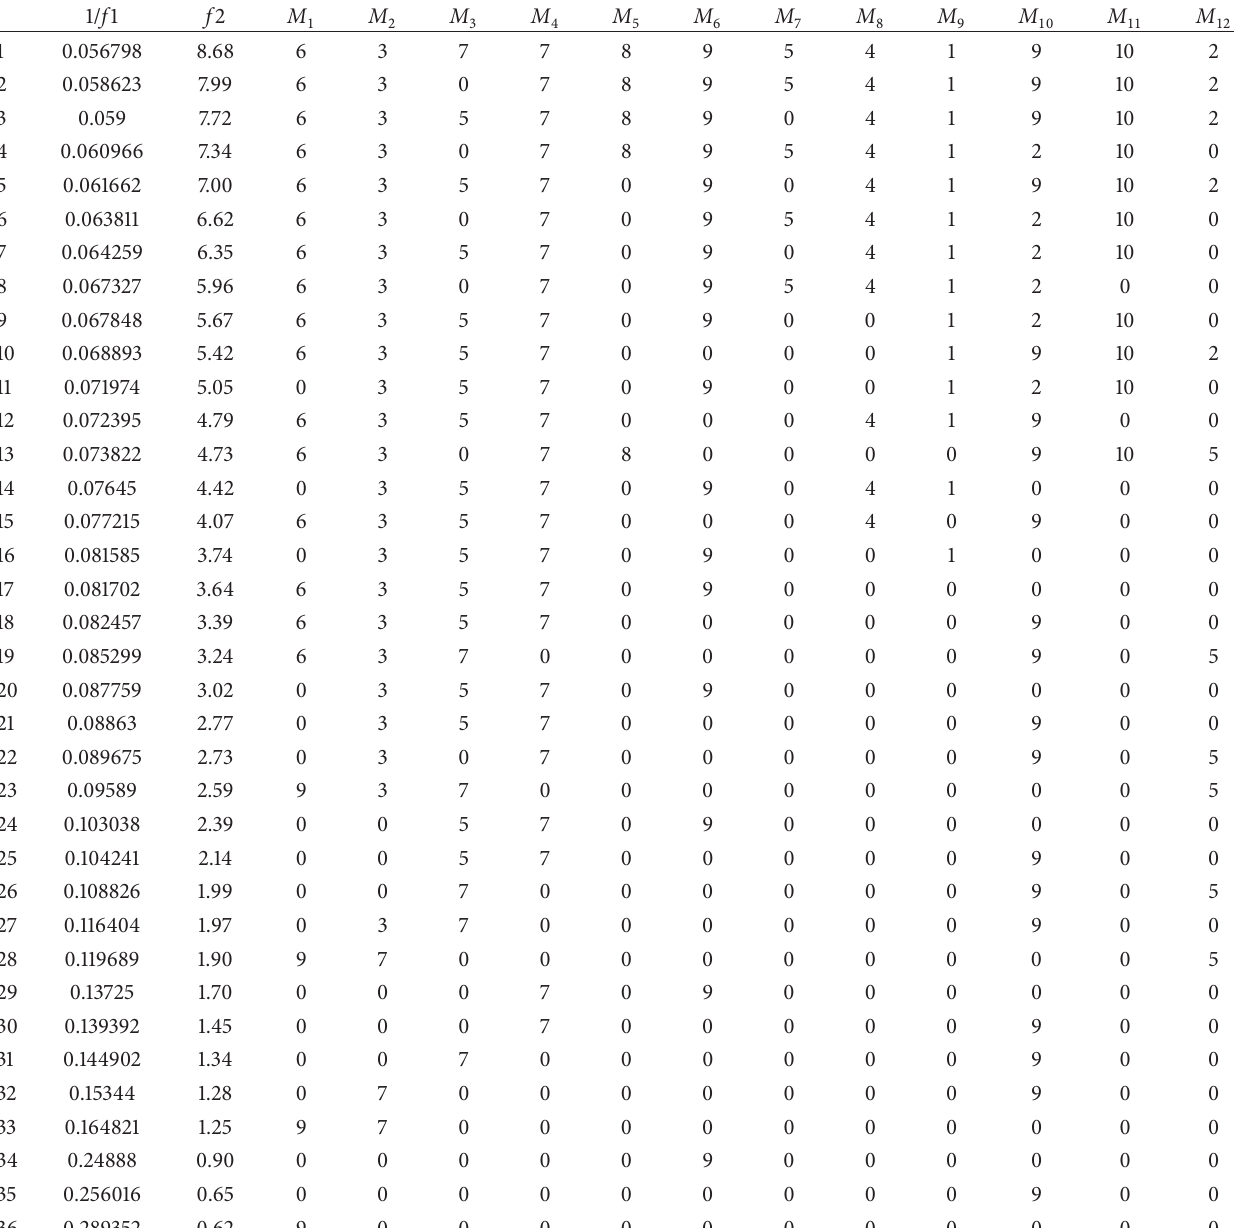
Table 8: The value of PSs and results of WTA distribution.